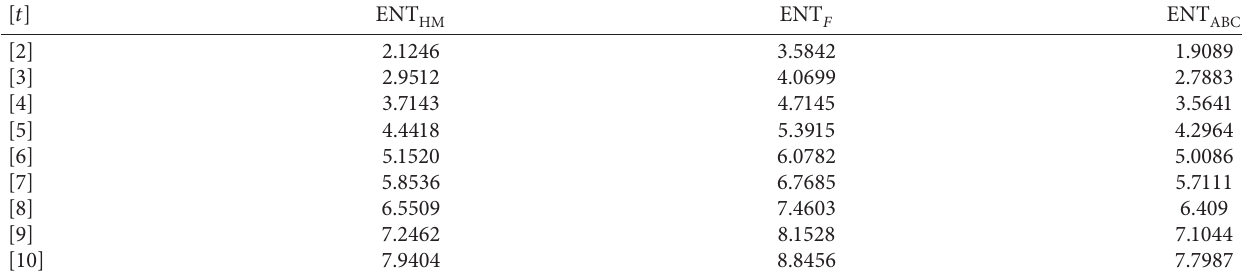
, ENT F , and ENT ABC for CBT ( t ) . HM ENT F ENT